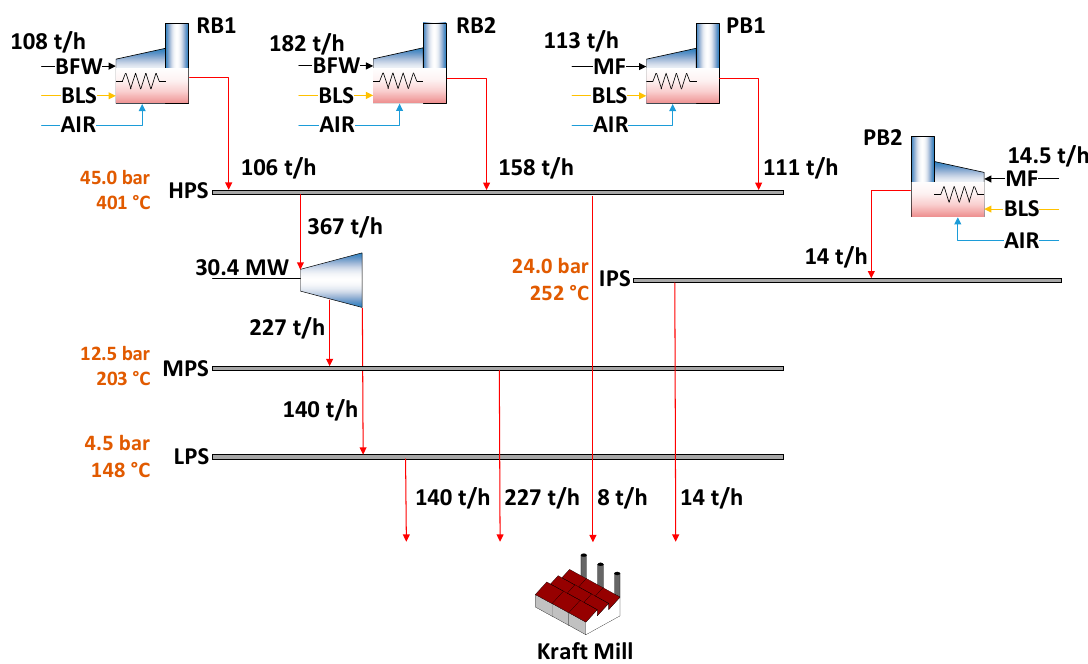
Figure 2. Simplified utility system of the existing kraft mill.